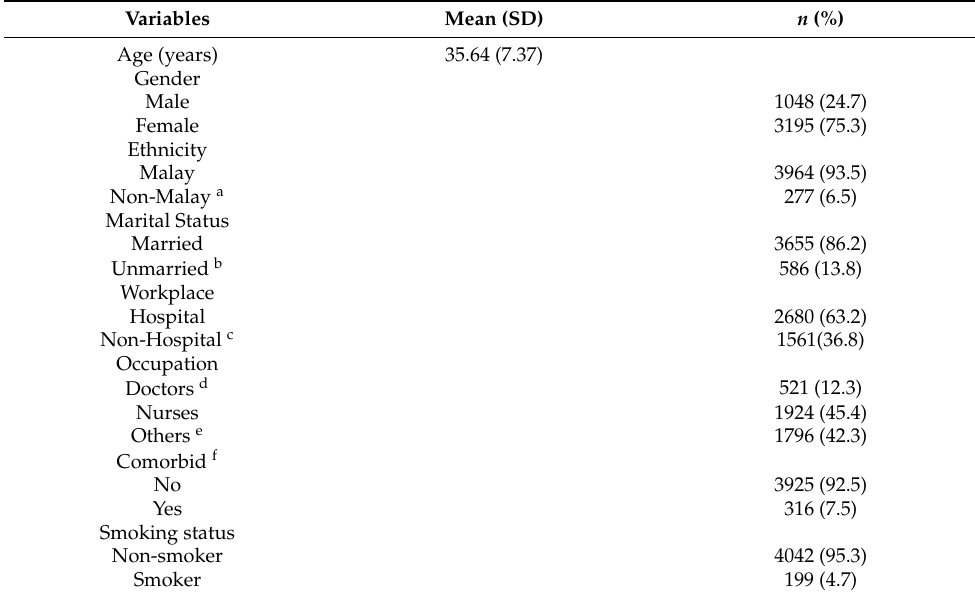
Table 1. Sociodemographic characteristics of study subjects ( n = 4241).